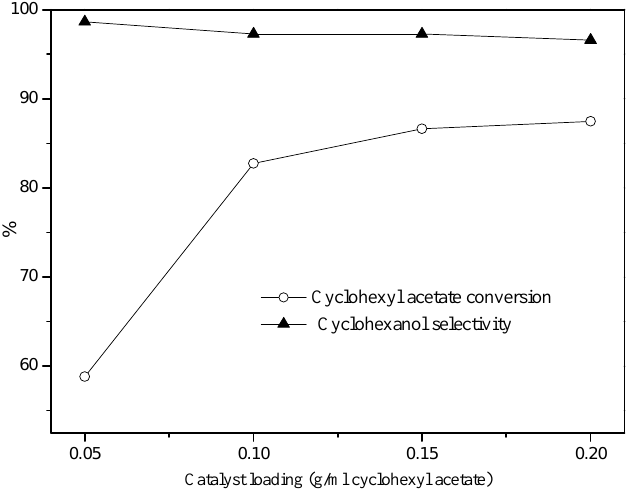
Figure 8. Effect of catalyst loading on the hydrolysis of cyclohexyl acetate over the CSALA. Reaction conditions: cyclohexyl acetate 8 mL (55 mmol), H 2 O 40 mL (2222 mmol), 130 °C, 3 h. conditions: cyclohexyl acetate 8 mL (55 mmol), H